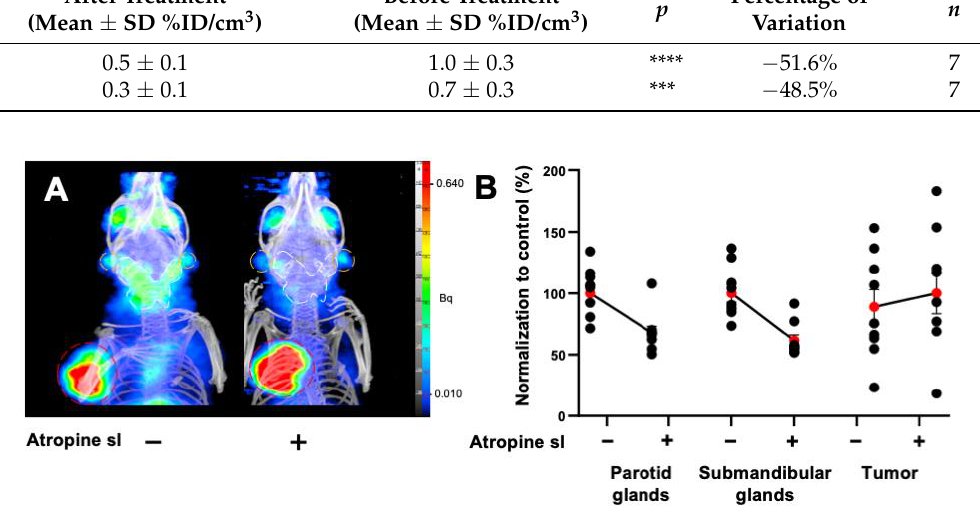
Figure 3. ( A ) Representative MIP images of microPET/CT biodistribution of [ 68 Ga]Ga-PSMA-11 in parotid glands and submandibular glands in mice xenografted with prostate adenocarcinoma cells premedicated by atropine sublingually, at 15 mg kg −1 . The parotid glands are encircled in white, the submandibular glands are in orange, and the tumor is in red. ( B ) Normalized quantification of [ 68 Ga]Ga-PSMA-11 in the parotids, submandibular glands, and tumor in prostate-tumor-bearing mice. The red point represents the mean ± SEM; black points represent the sample dispersion.